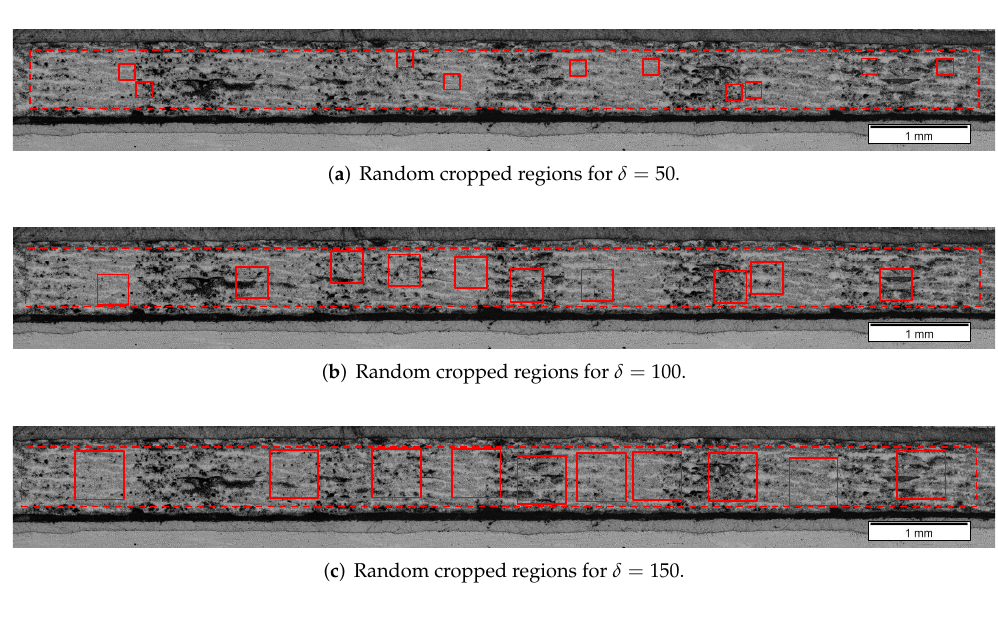
= { V ≤ V ≤ 0.320 } . f : 0.315 f f